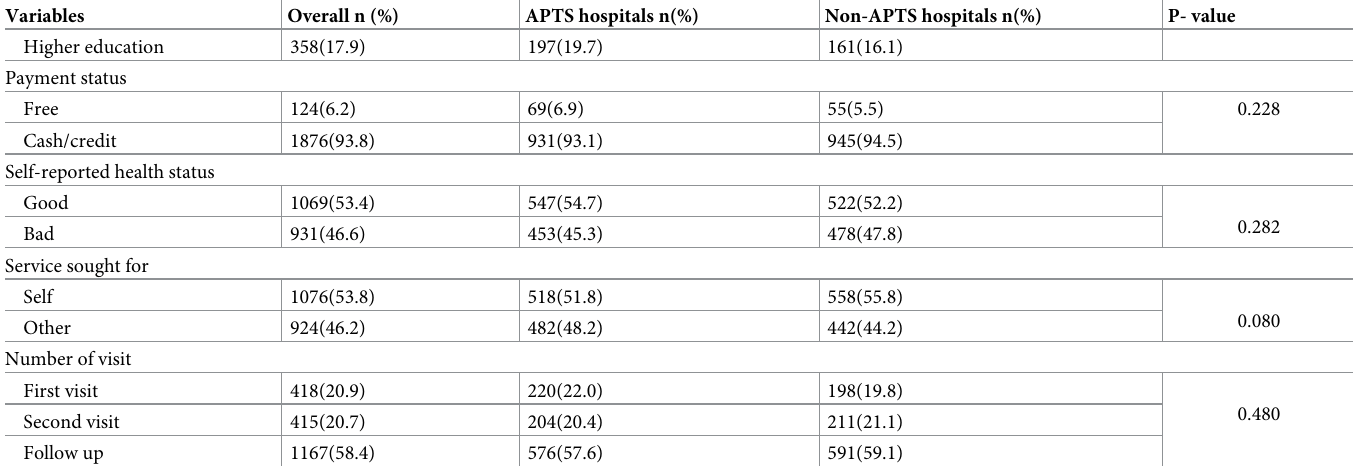
Table 2. Comparison of the socio-demographic characteristics and health care measures between study population of APTS and Non-APTS primary hospitals (continue).